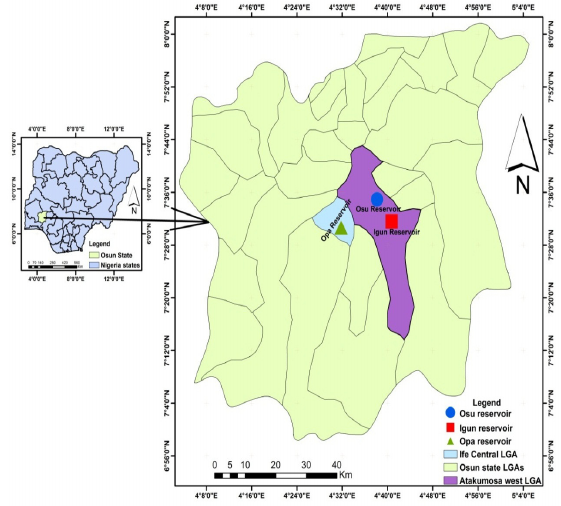
Fig. 1. Map of Osun State showing Opa, Osu and Igun reservoirs (Nigeria)